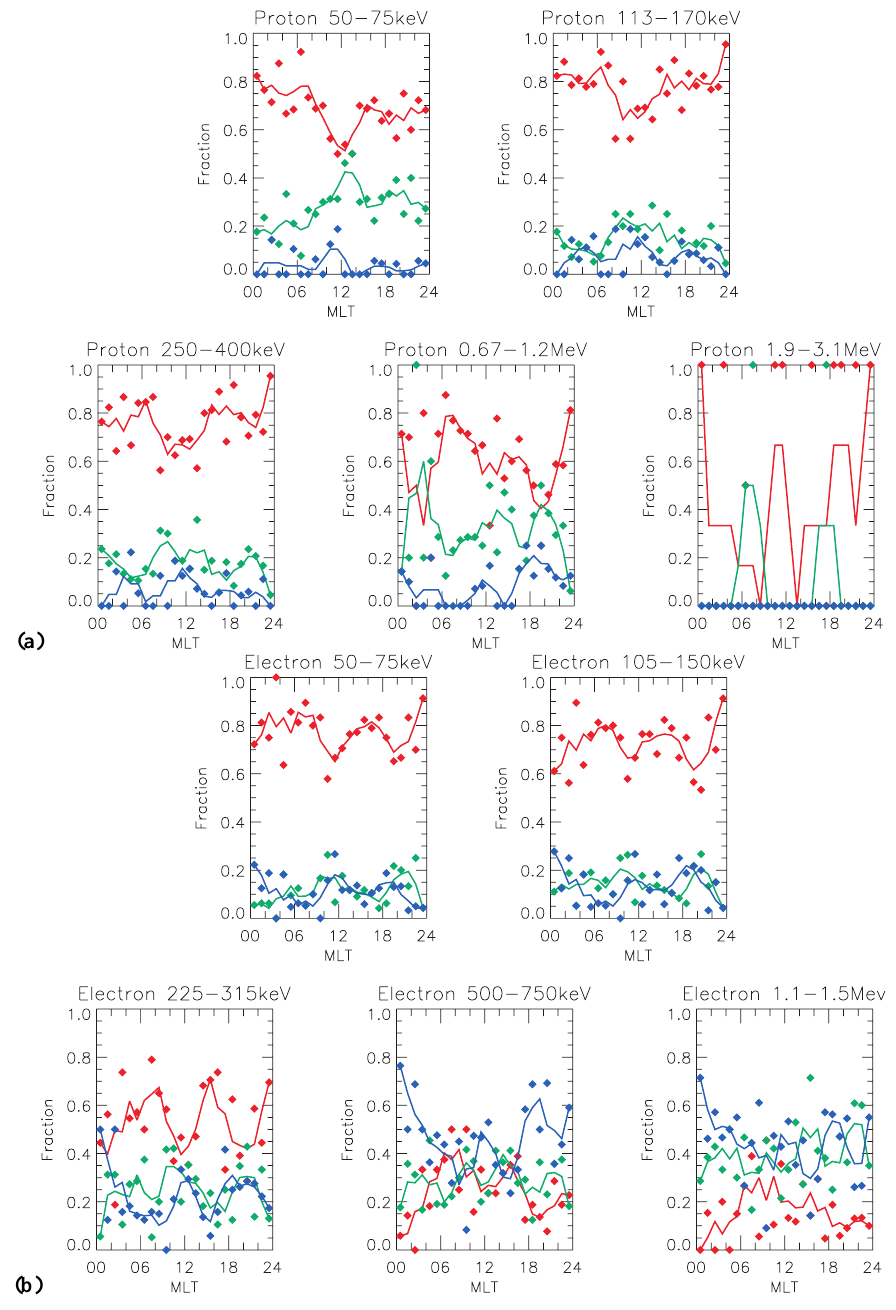
Fig. 2. (a) Local-time distribution of proton flux responses to the dynamic pressure enhancements for 5 selected individual energy channels. The red lines represent percentage of events showing flux increase; the green ones are percentage of events showing no discernible flux change and the blue ones are percentage of events showing flux decrease. (b) The same as panel (a), except that it if for